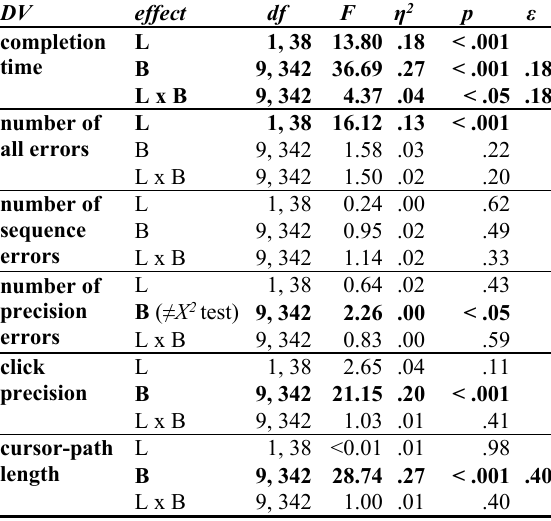
Table 1. ANOVA results of the learning phase of Experiment 1.